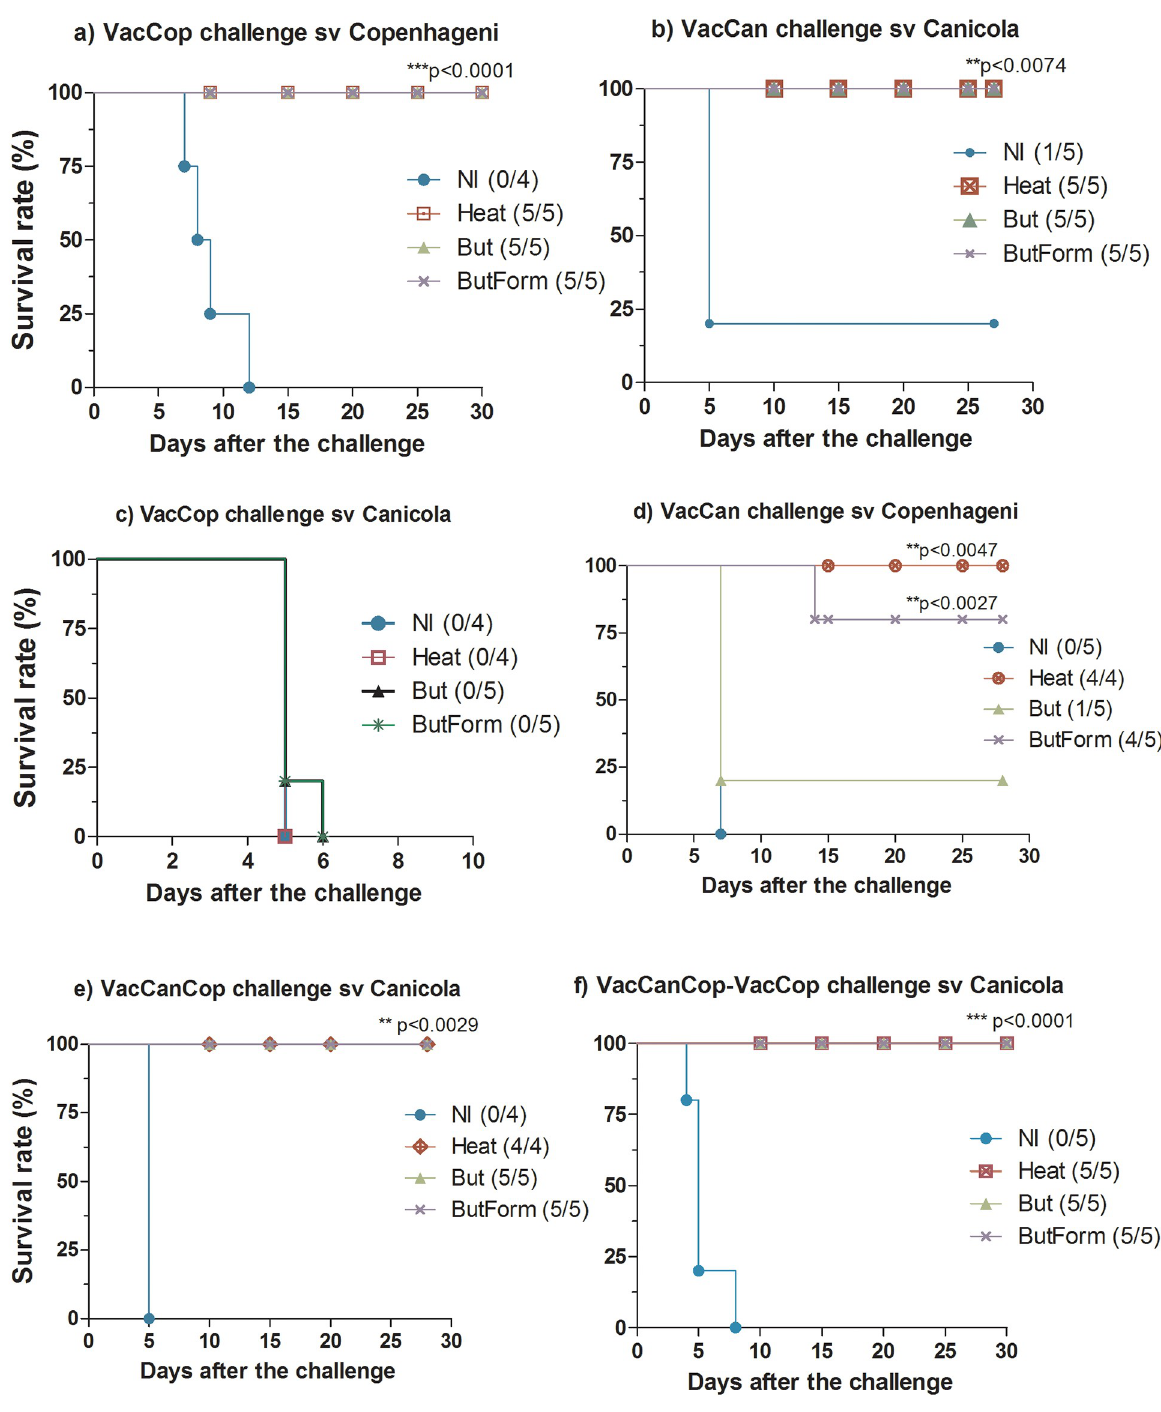
Fig 1. Protection of hamsters immunized and challenged with virulent Leptospira ; a and b) represent data obtained from animals immunized with L . interrogans sv Copenhageni and L . interrogans sv Canicola, respectively, after immunization, these animals were challenged with the virulent serovar homologous to that of the vaccine preparations; c) data from animals immunized with sv Canicola, and challenged with sv Copenhageni (heterologous challenge); d and e) represent data obtained with bivalent vaccines (VacCanCop). The first groups (d) received two doses of bivalent formulations, and (e) received the bivalent vaccine as first dose and second dose contained only the serovar Copenhageni (VacCop). Animals represented in graphic (d) and (e) were challenged with Canicola serovar after immunizations. Statistical analyzes were performed comparing survival curves by Log-rank (Mantel-Cox), followed by Gehan-Breslow-Wilcoxon test using GraphPad Prism software.